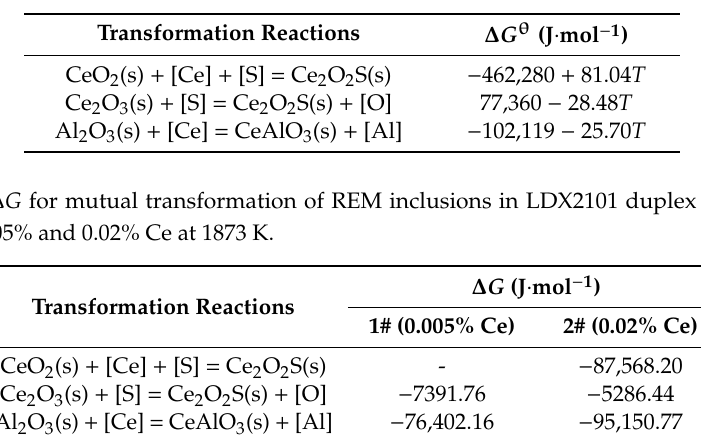
Table 5. Possible transformation reactions between REM inclusions and their ∆ G θ .